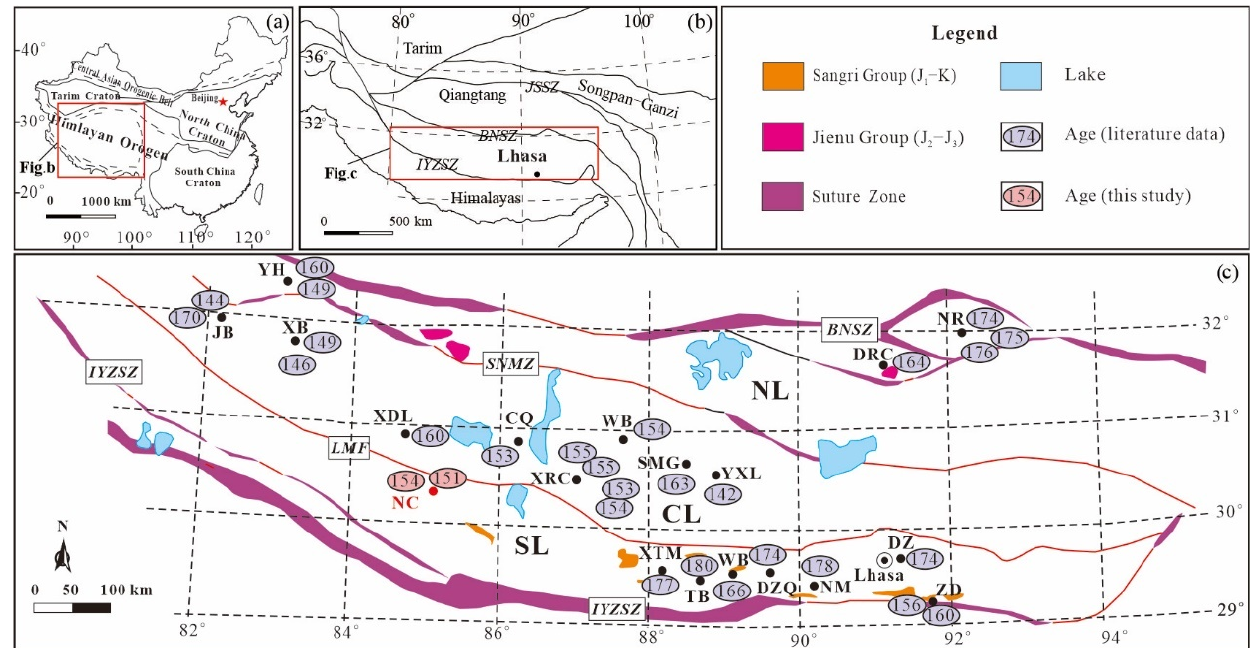
Figure 1. ( a ) Simplified structural map of China; ( b ) tectonic framework of the Himalayan − Tibetan plateau; ( c ) Simplified geologic map of the Lhasa terrane showing the major tectonic subdivisions, distribution of Mid-Late Jurassic granitoids [4,5,7,11,16,23–26] and position of the study area [4]. IYZSZ—Indus-Yarlung Zangbo Suture Zone; LMF—Luobadui-Milashan Fault; GLZCF − Gar-Lunggar − ZhariNam Tso − Comai Fault; SNMZ—Shiquan River-Nam Tso M é lange Zone; BNSZ—Bangong-Nujiang Suture Zone; NL—northern Lhasa terrane; CL—central